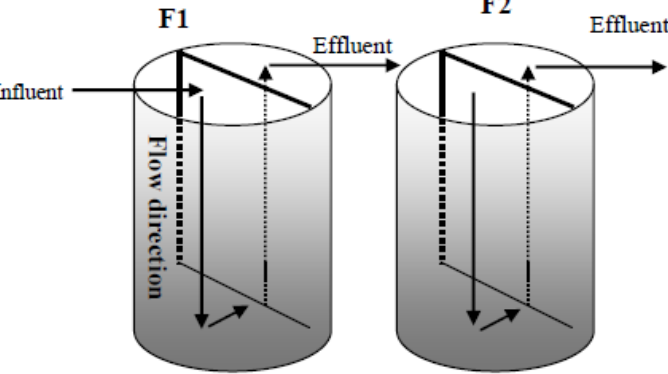
Figure 1. Phosphorus filters design. In order to facilitate sampling, and maintain the same flow path baffles that were installed in each filter in series. The first half of each filter was fed from the top to the bottom, while the second half was fed from the bottom to the top of a